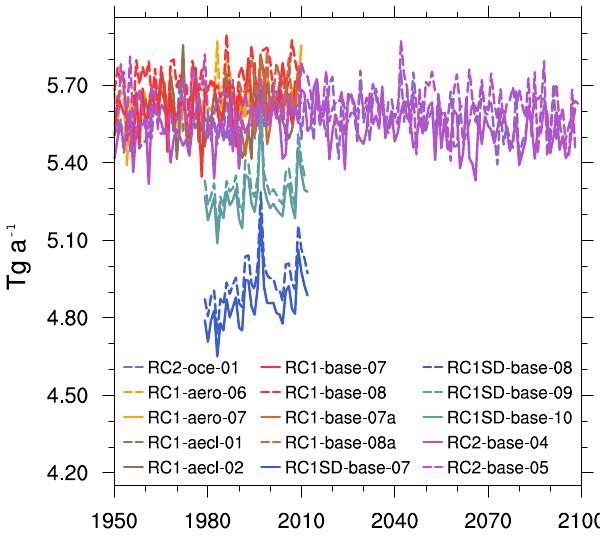
Figure 8. Simulated annual total emissions of Br from sea salt (in Tg ( Br ) a − 1